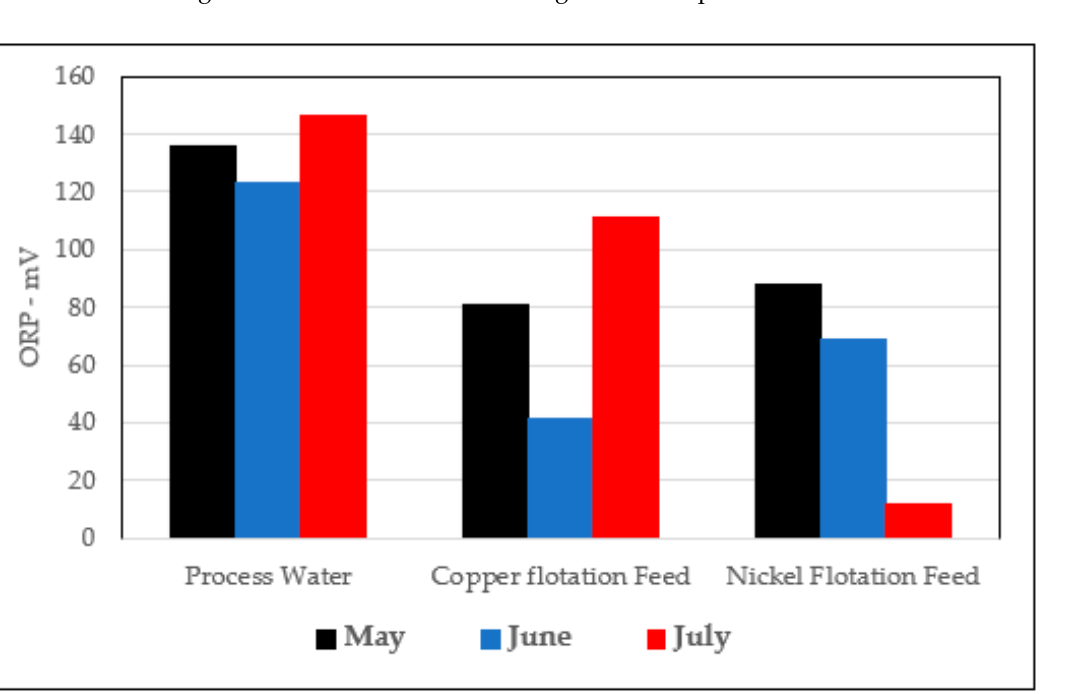
Figure 7. ORP change from process water to nickel flotation feed.